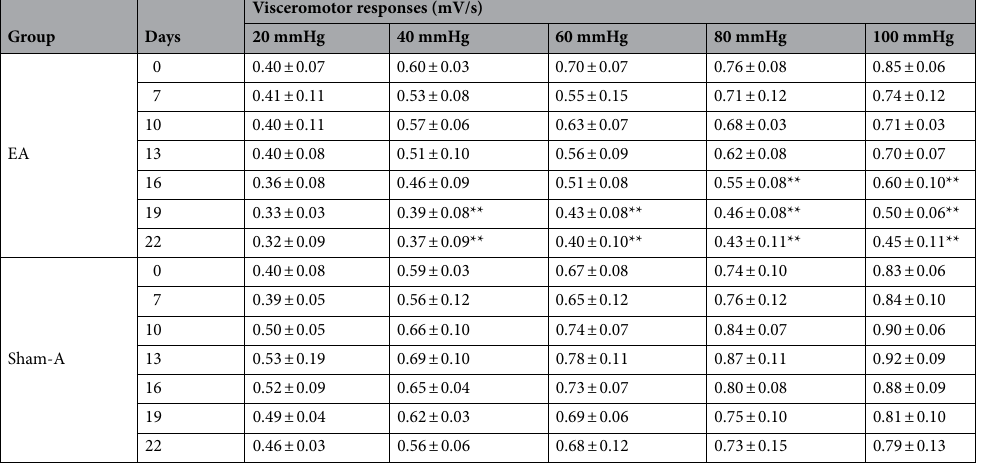
The magnitude of VMR to 40–100 mmHg [F (6, 35) = 7.613, P = 0.000 for days 19 and 22 with 40 mmHg; F(6, 35) = 6.738 for 22, P = 0.000 for days 19 and 22 with 60 mmHg; F(6, 35) = 12.690, P = 0.000 for days 16, 19 and 22 with 80 mmHg; F(6, 35) = 17.432, P = 0.000 for days 16, 19 and 22 with 100 mmHg] decreased ( P < 0.01) further with repetitive EA applications at days 19 and 22 (Table 1). However, the sham-acupuncture did not change VMR during the experiment.